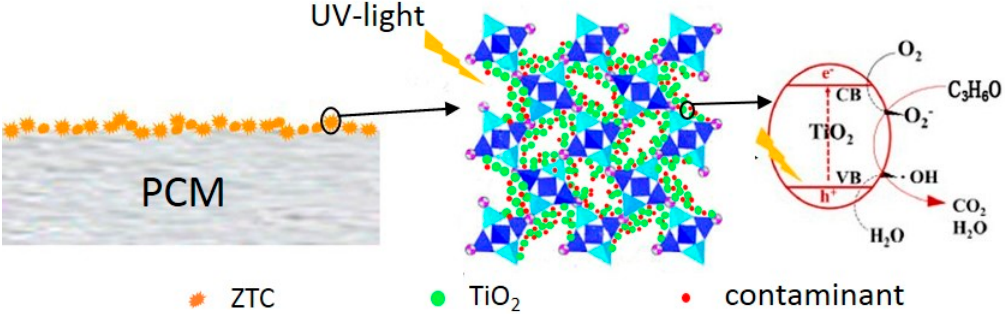
Figure 7. The photocatalysis mechanism of the PCM.